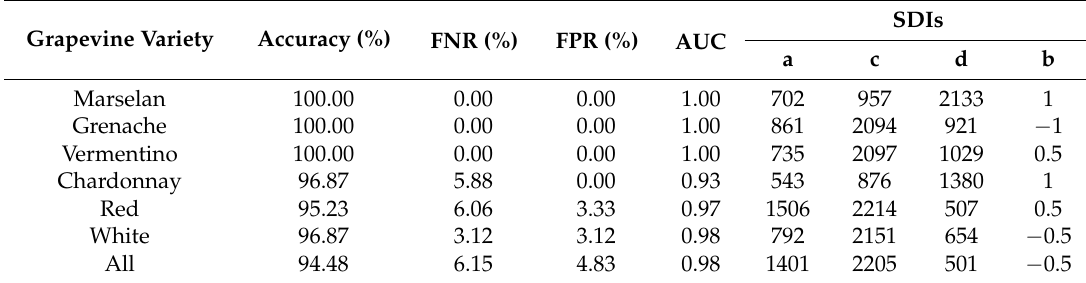
Table 9. Results of using SDIs in classifying different groups of spectral data acquired in the August acquisition campaign (Severity of infestation = 1).